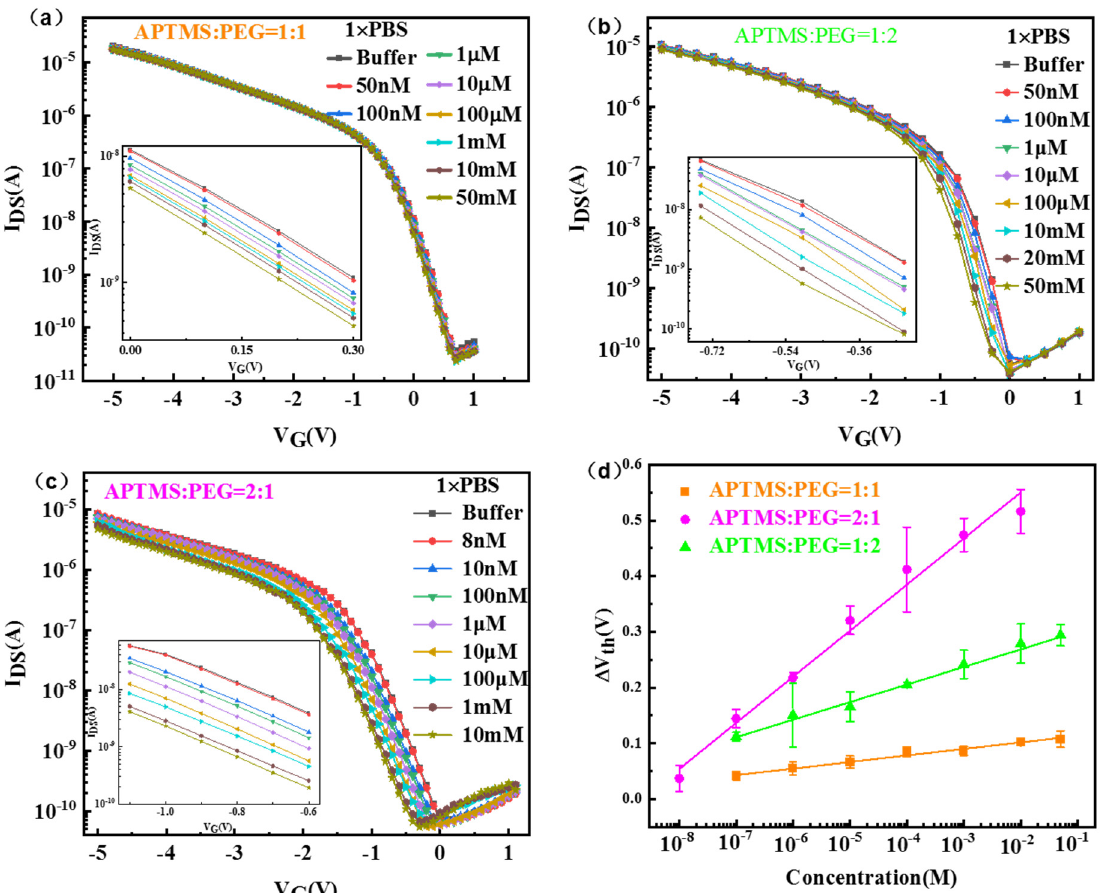
Figure 4. Electrical properties of three types of APTMS/PEG/SiNW − FET glucose biosensors for glucose detection. ( a ) APTMS:silane ‐ PEG = 1:1. ( b ) APTMS:silane ‐ PEG = 1:2. ( c ) APTMS:silane ‐ PEG = 2:1. ( d ) The plot of the voltage offsets produced by the APTMS/PEG/SiNW − FET glucose biosensor and its corresponding calibration line as a function of glucose concentration. APTMS:silane ‐ PEG = 1:1 (orange): The fitted linear relationship is y = 0.12 + 0.01x, and the linear correlation coefficient (R 2 ) is 0.9855; APTMS:silane ‐ PEG = 1:2 (green): The fitted linear relationship is y = 0.33 + 0.03x, R 2 = 0.9903; APTMS:silane ‐ PEG = 2:1 (purple): Fitted linear relationship y = 0.71 + 0.08x, R 2 = 0.9978.